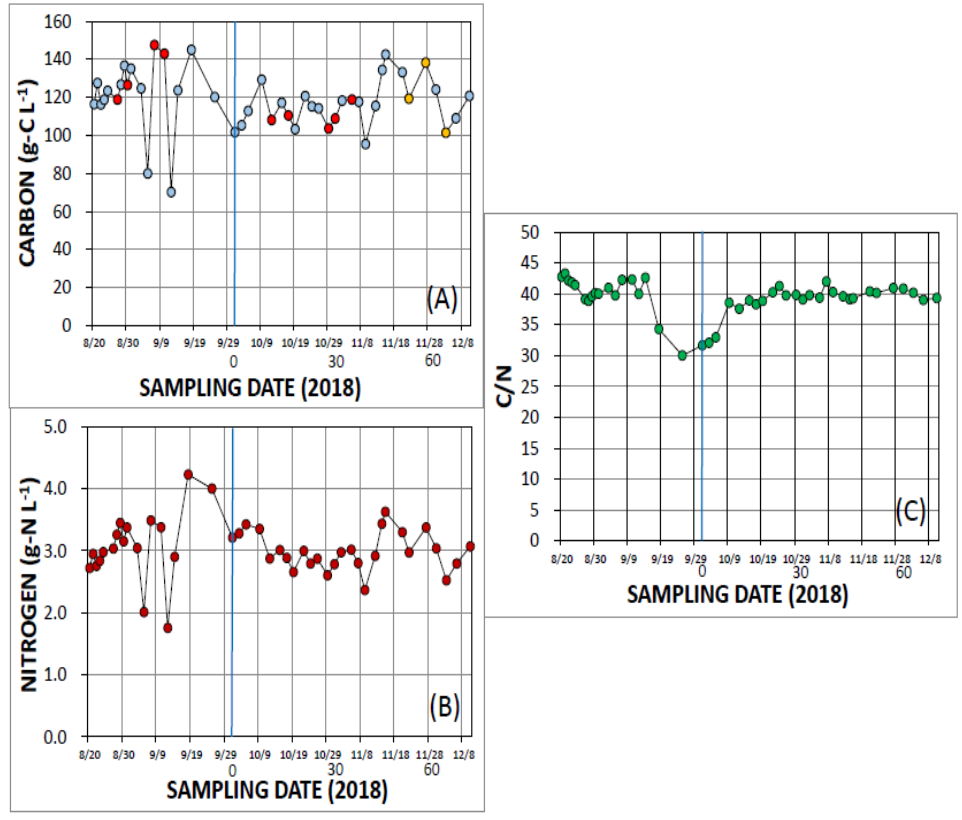
Figure 3. Changes in the concentrations of organic carbon ( A ), organic nitrogen ( B ), and the carbon: nitrogen ratio (C/N) ( C ) in the emulsion-type cutting fluid (E-CF). Occasions of supplying diluted fresh E-CF are shown by red circles and those supplying only tap water are shown by orange circles ( A ). Blue vertical lines show the day when bubbling with microbubbles was initiated (1 October). Numbers of 0, 30, and 60 below the date in each figure show days after starting to supply microbubbles.